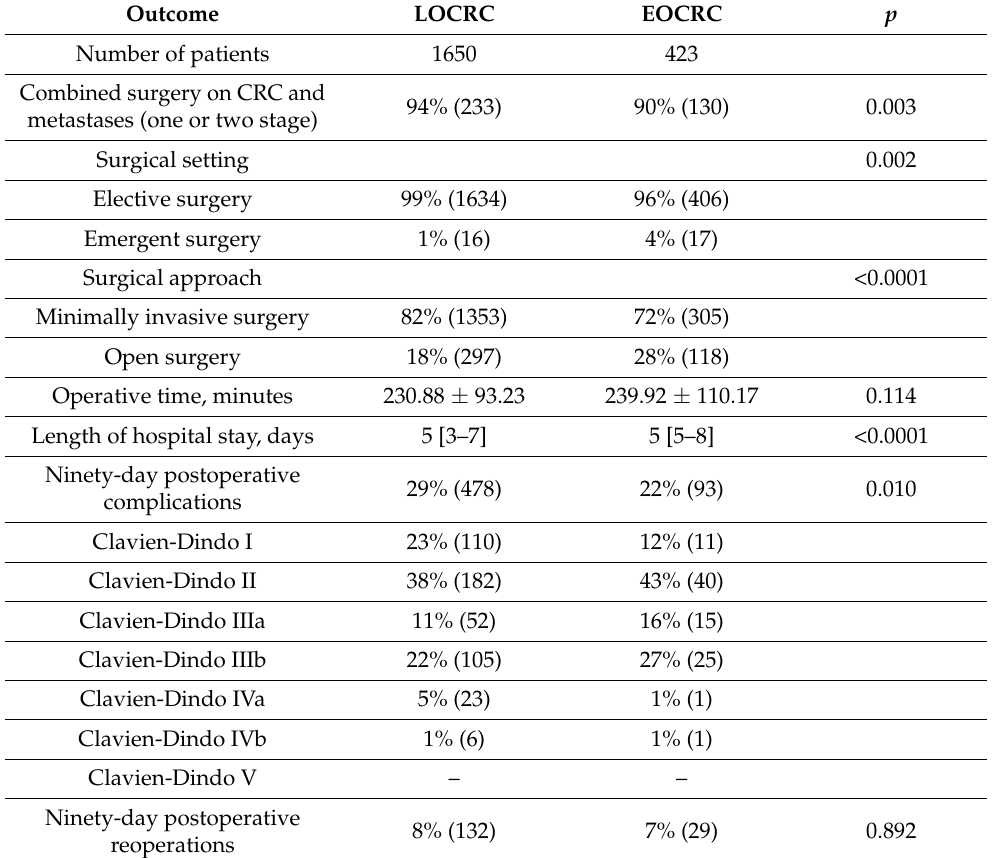
Table 2. Operative data and postoperative outcomes, mean ± standard deviation, median [IQR], and % (n).